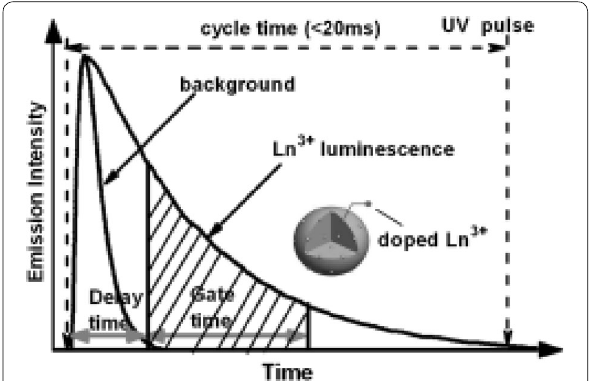
Fig. 6 Mechanism of time‑resolved fluorescence as a means of elimi‑ nating short lifetime background and autofluorescence (reproduced from [86] with permission, (C) 2011 John Wiley &